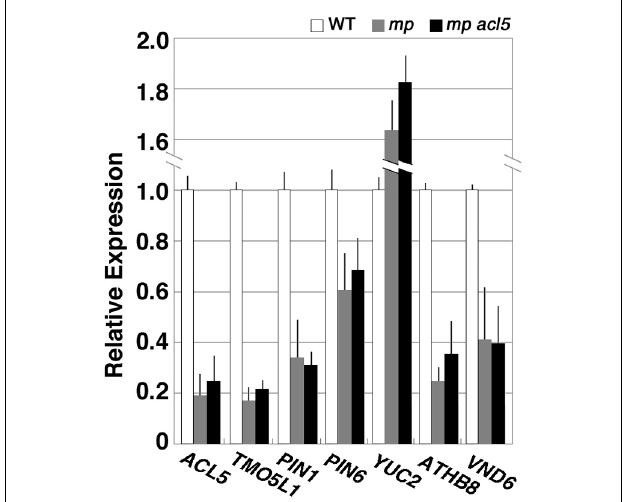
FIGURE 4 | Expression of thermospermine-responsive genes in the mp mutant. Total RNA was prepared from seedlings of the L er wild type (white bars), mp (gray bars), and mp acl5-1 (black bars) grown for 7 days in MS agar plates. All transcript levels are relative to those in wild-type seedlings. Error bars represent the SE ( n =